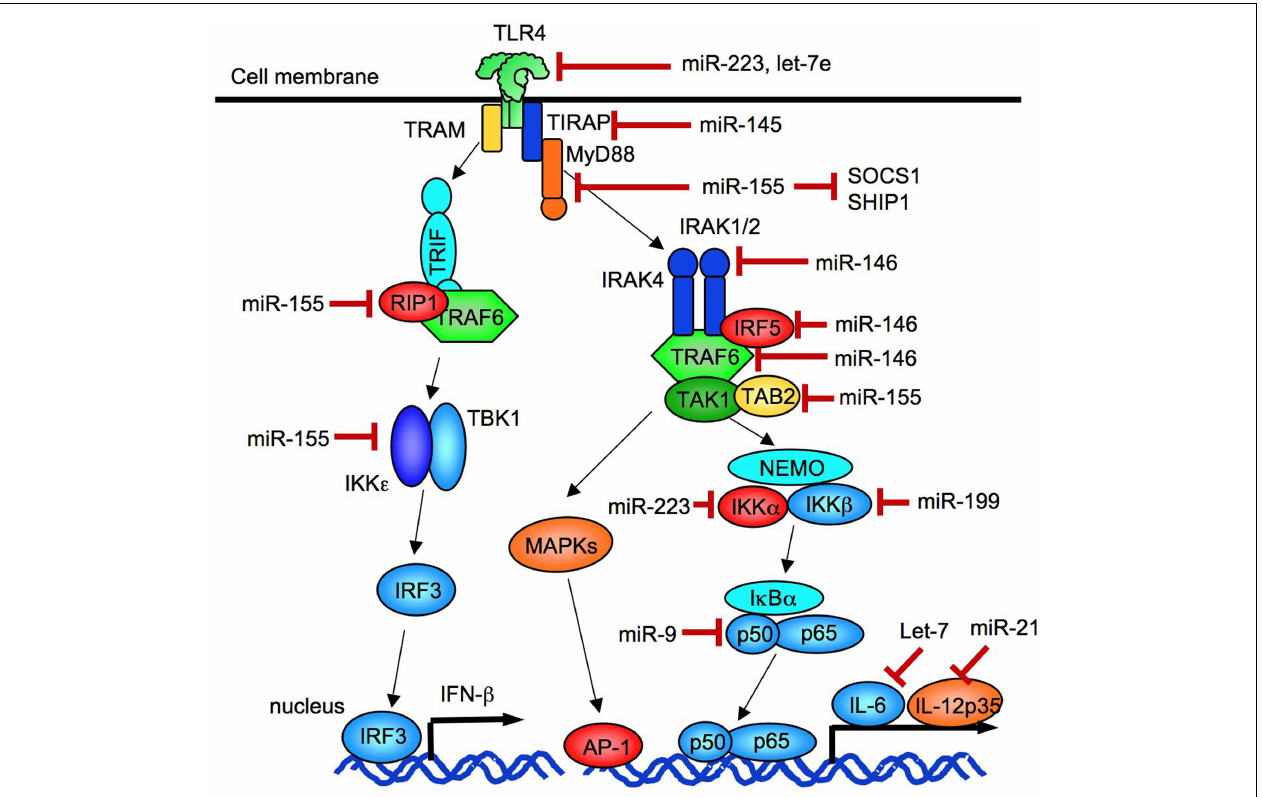
the expression ofTAB2, RIP1, IKK ε , SOCS-1, andTIRAP. miR-223 suppresses the expression ofTLR4 and IKK α , and miR-9 inhibits the expression of an NF- κ B p50 subunit.